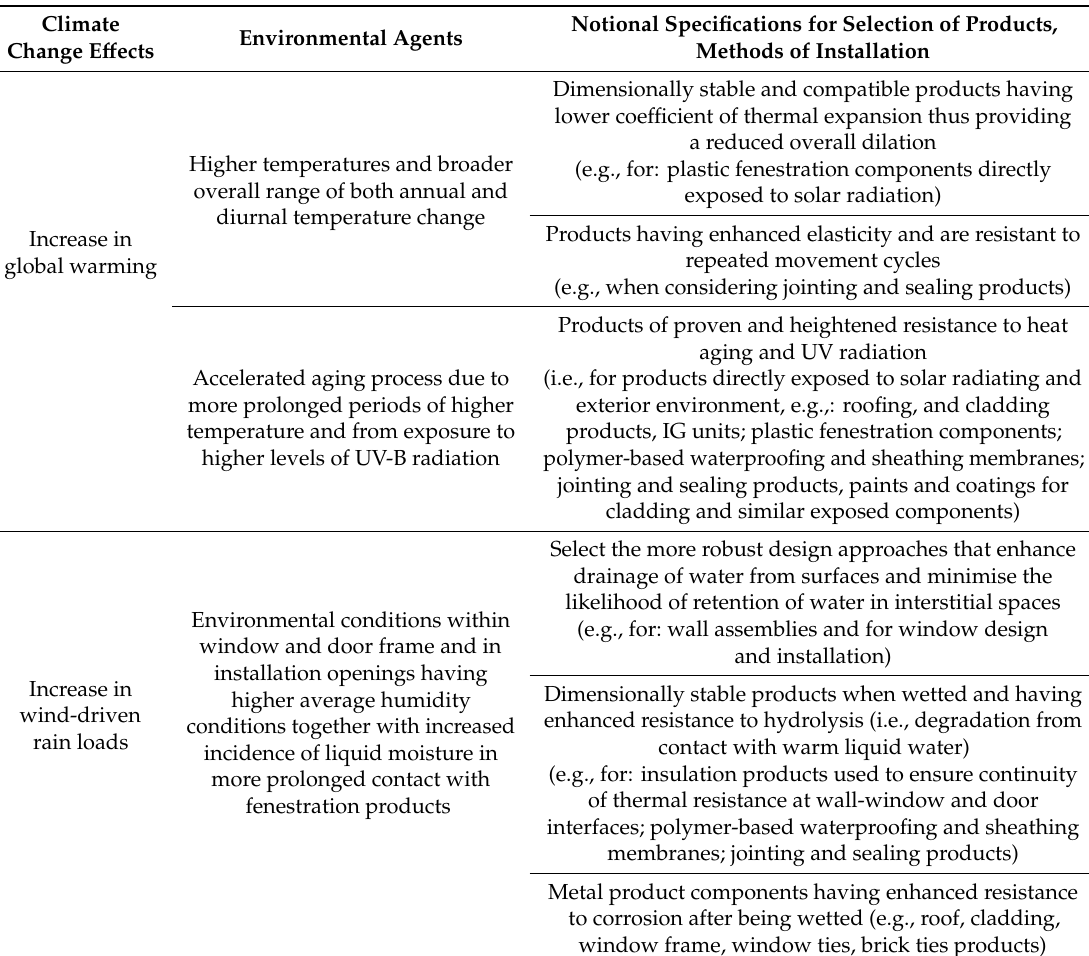
Table 1. Notional specifications for the selection of products given climate change e ff